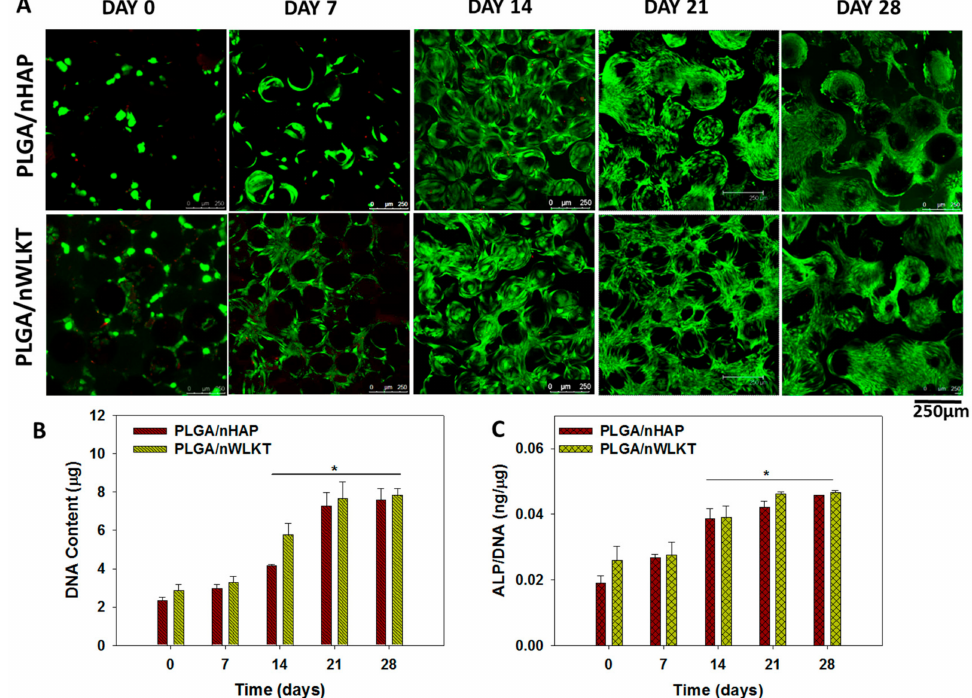
Figure 6. ( A ) Cell viability assessment of BMSCs in PLGA / nHAP and PLGA / nWLKT microsphere sca ff olds through Live / Dead staining (bar = 250 µ m). The quantitative estimation of cell proliferation and osteogenic di ff erentiation of BMSCs seeded in the microsphere sca ff olds was determined from DNA content ( B ) and normalized ALP activity ( C ) (* p < 0.05 compared to day